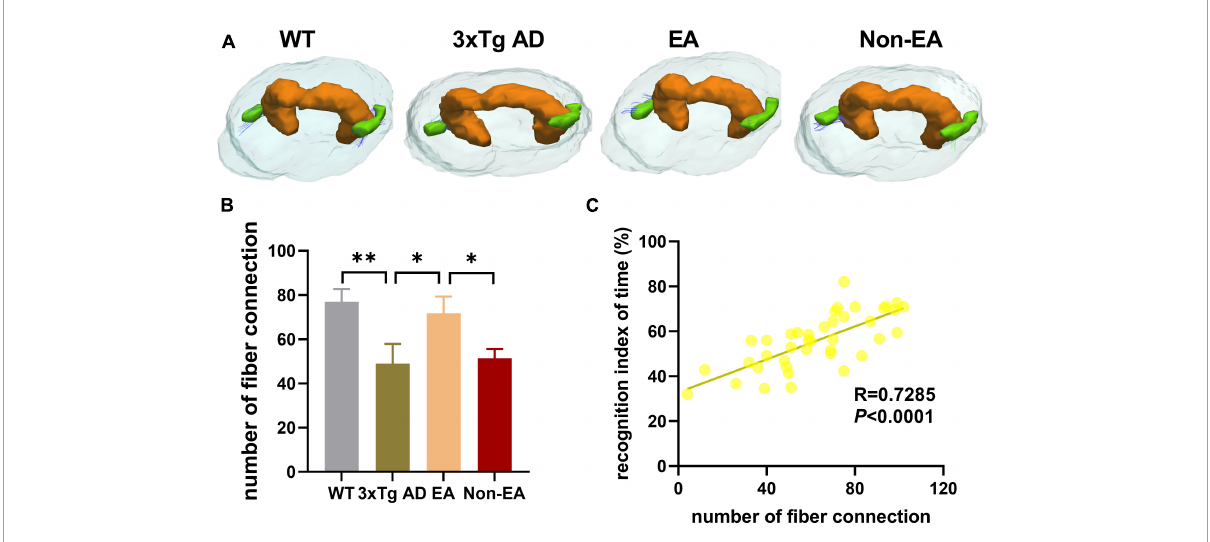
FIGURE7 Effects of the EA-treatment on fiber connection between the hippocampus and entorhinal cortex. (A) Representative image of connected nerve fibers between hippocampus and entorhinal cortex in all group. (B) Quantification of the number of nerve fibers connection between the hippocampus and entorhinal cortex, (C) and the correlational analysis between the recognition index of time and the number of nerve fibers connection ( n = 10 in each group). All data represent the mean ± SEM. ∗ P < 0.05; ∗∗ P < 0.01.